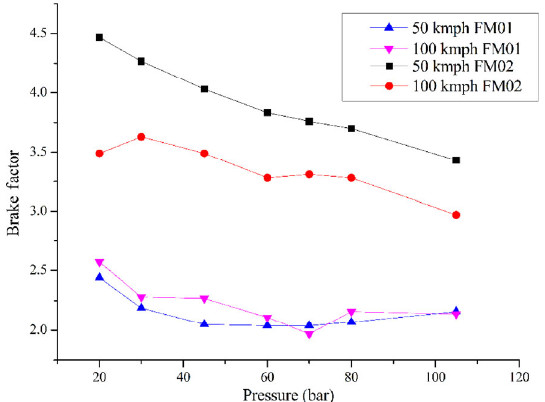
Fig. 4 Unbedded performance of developed friction